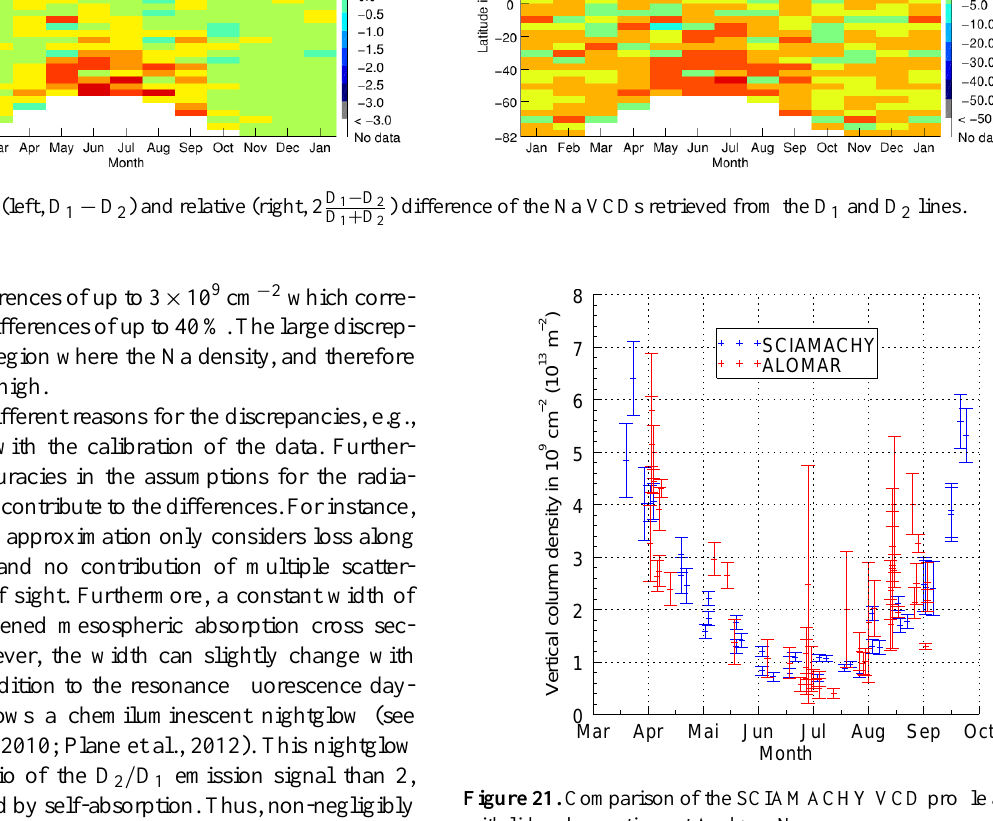
Figure 21. Comparison of the SCIAMACHY VCD profile at 69 ◦ N with lidar observations at Andøya,